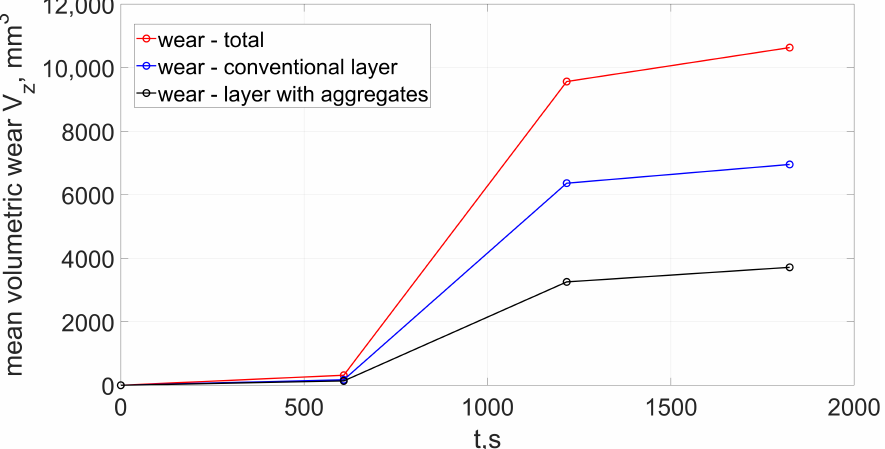
Figure 7. Total mean volumetric wear ¯ V z of the grinding wheel (Equation (31)).